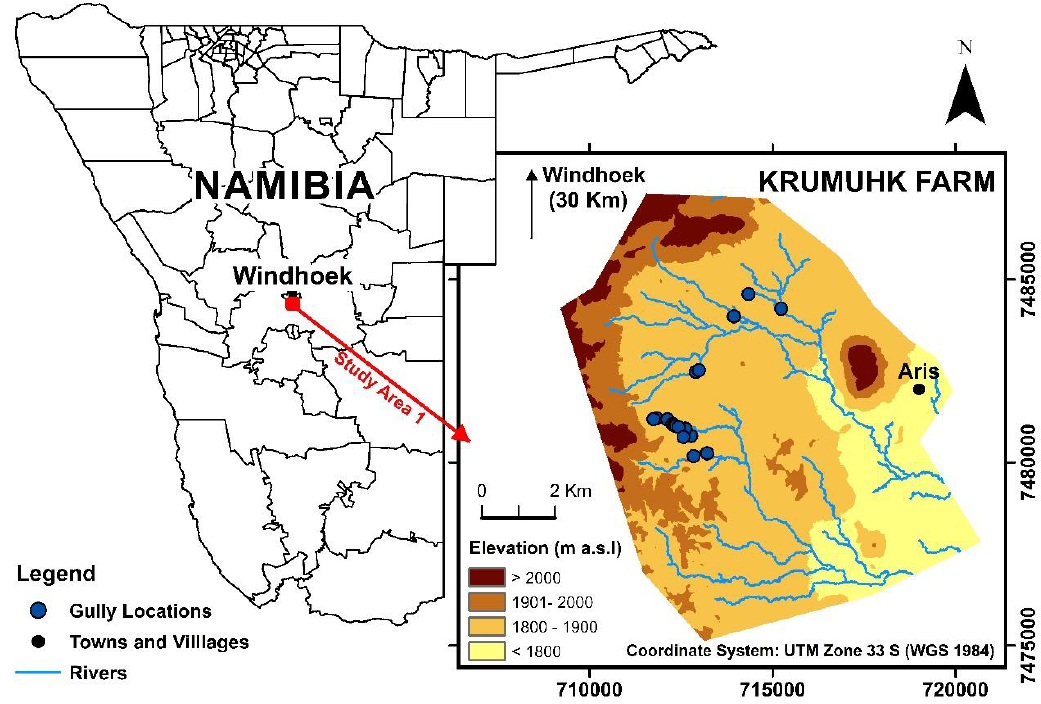
Figure 1. Location of the study area (Krumhuk Farm) and existing georeferenced gullies. Gully Locations (blue points) are part of the database of gullies treated during SASSCAL Task 41 [12] implementation.